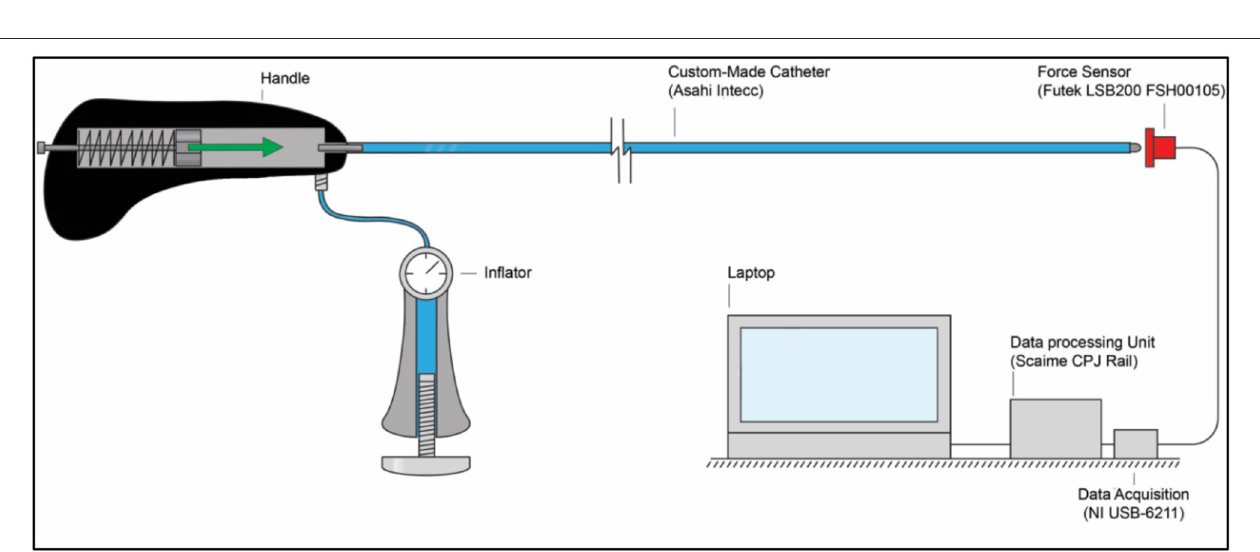
FIGURE 8 | Experimental facility. The experimental facility consisted of the Wave catheter connected to the inflator, a force sensor (Futek LSB200 FSH00105), a data acquisition unit (National Instruments NI USB-6211), a data processing unit (Scaime CPJ Rail), and a laptop. The green arrow indicates the acceleration and motion of the mass-spring system inside the